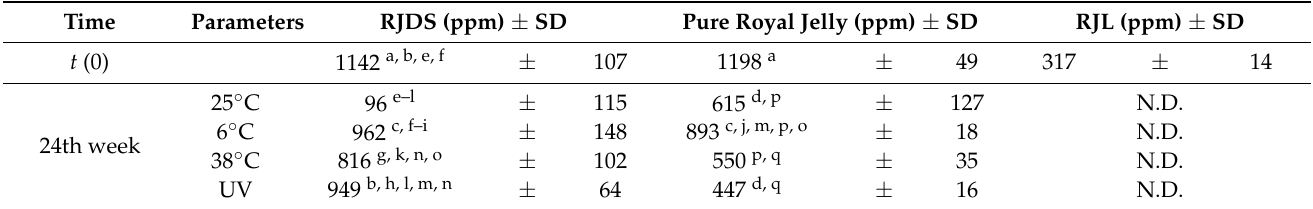
Table 2. Stability test for 10-HDA: 10-hydroxy-2-decenoic acid ( ± SD), of RJDS versus pure royal